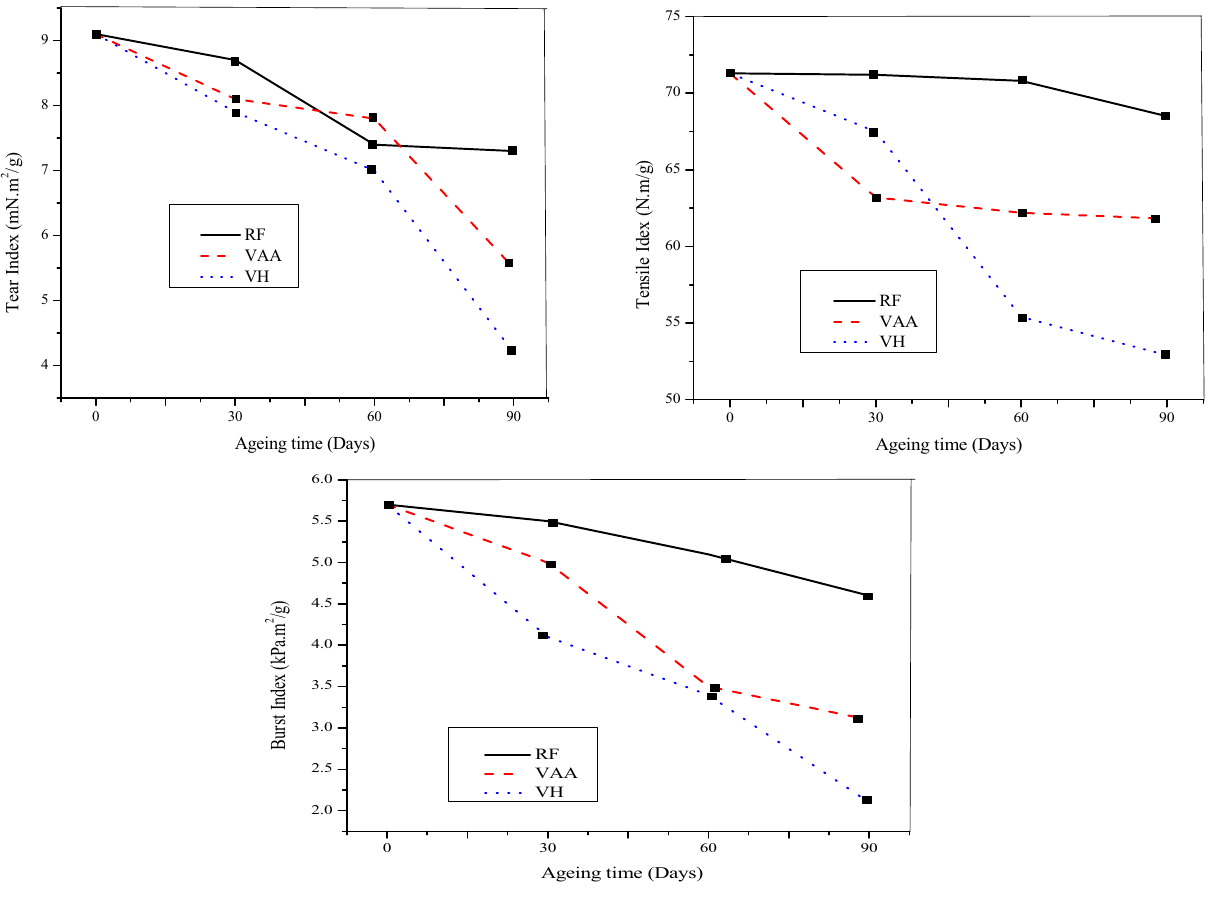
Figure 2. Effects of VOCs expose on mechanical properties of paper